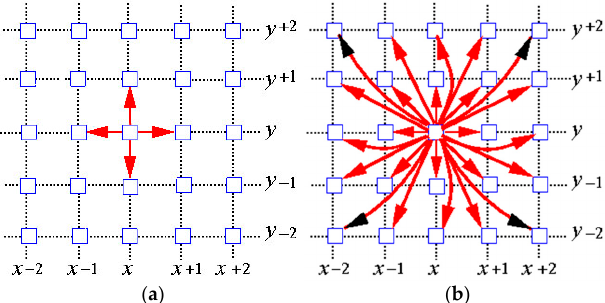
Figure 7. Comparison of the short-range CRF and the fully connected CRF models. ( a ) In the short-range CRF, only the 4 nearest neighbors are connected to a certain node; ( b ) in the fully connected CRF, every two nodes are connected by an edge (from [59]).